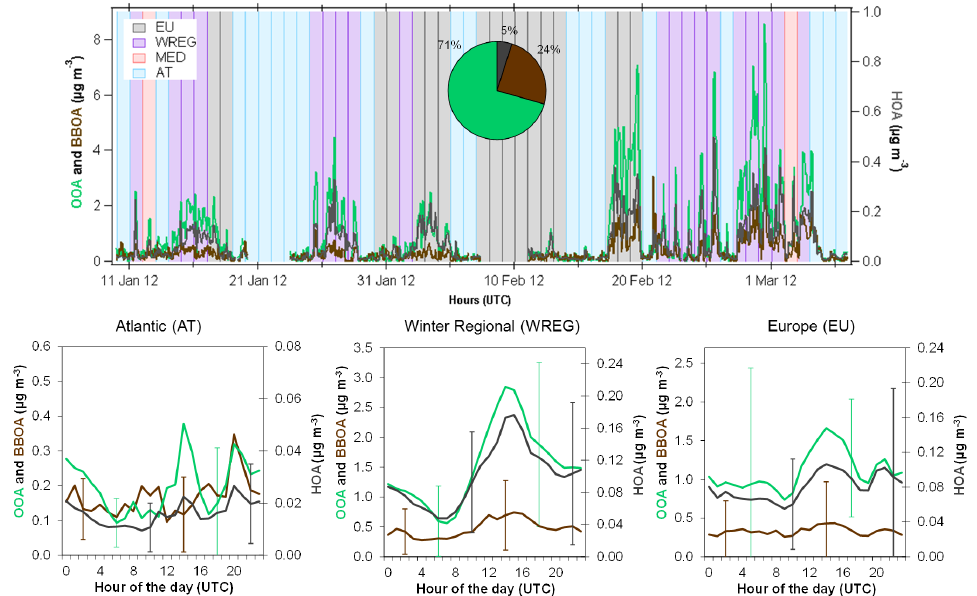
Figure 9. Top: time series of organic species (hydrocarbon-like organic aerosol (HOA), biomass burning organic aerosol (BBOA) and oxygenated organic aerosol (OOA)) concentrations in winter (10 January 2012–7 March 2012). Background colors correspond to daily classification of atmospheric episodes and the pie chart correspond to the average organic species composition for the winter period. Bottom: diurnal cycles of organic species concentrations averaged as a function of atmospheric episode for the winter period. Variation bars indicate ± standard